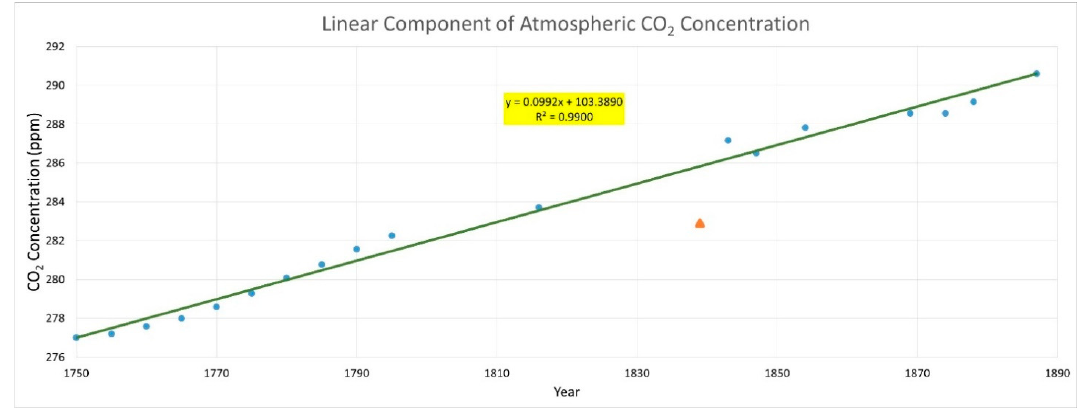
Figure 7. Atmospheric CO 2 concentrations with no fossil fuel combustion / cement production emissions inputs (Note: 1839 data point removed from analysis).